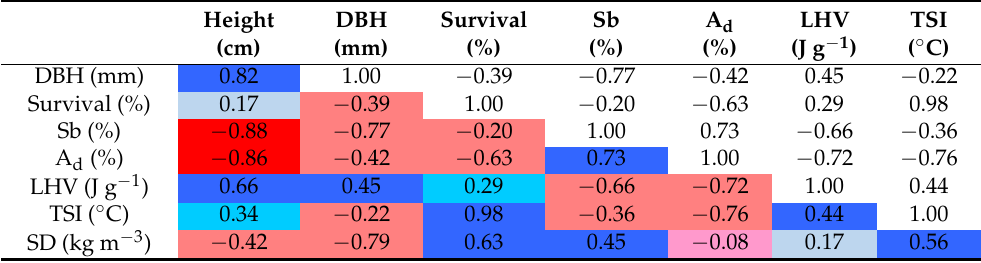
Table 5. Correlation coefficients between the studied traits. Blue tones indicate a positive correlation, and red tones a negative relationship.